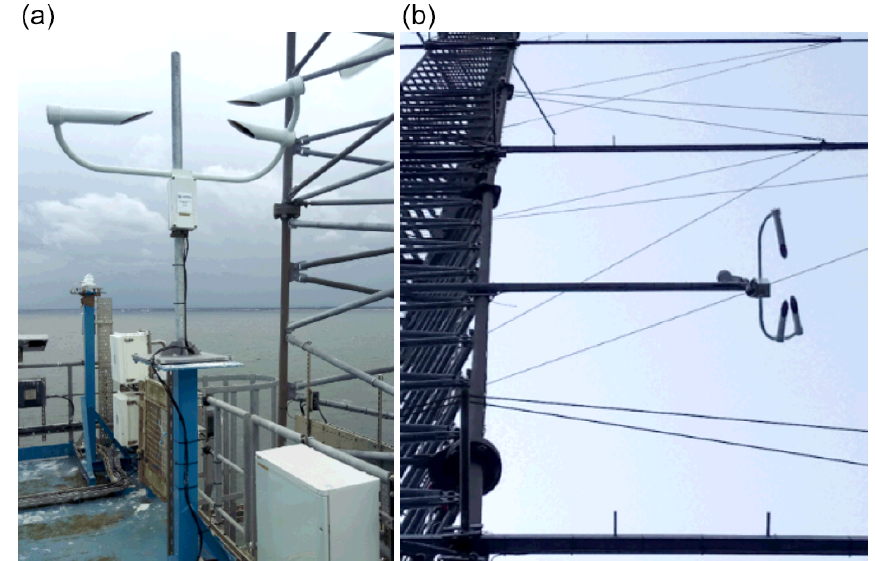
Figure 1. The optical disdrometers mounted to the platform (a) and at 55ma.s.l. (above sea level) (b) .